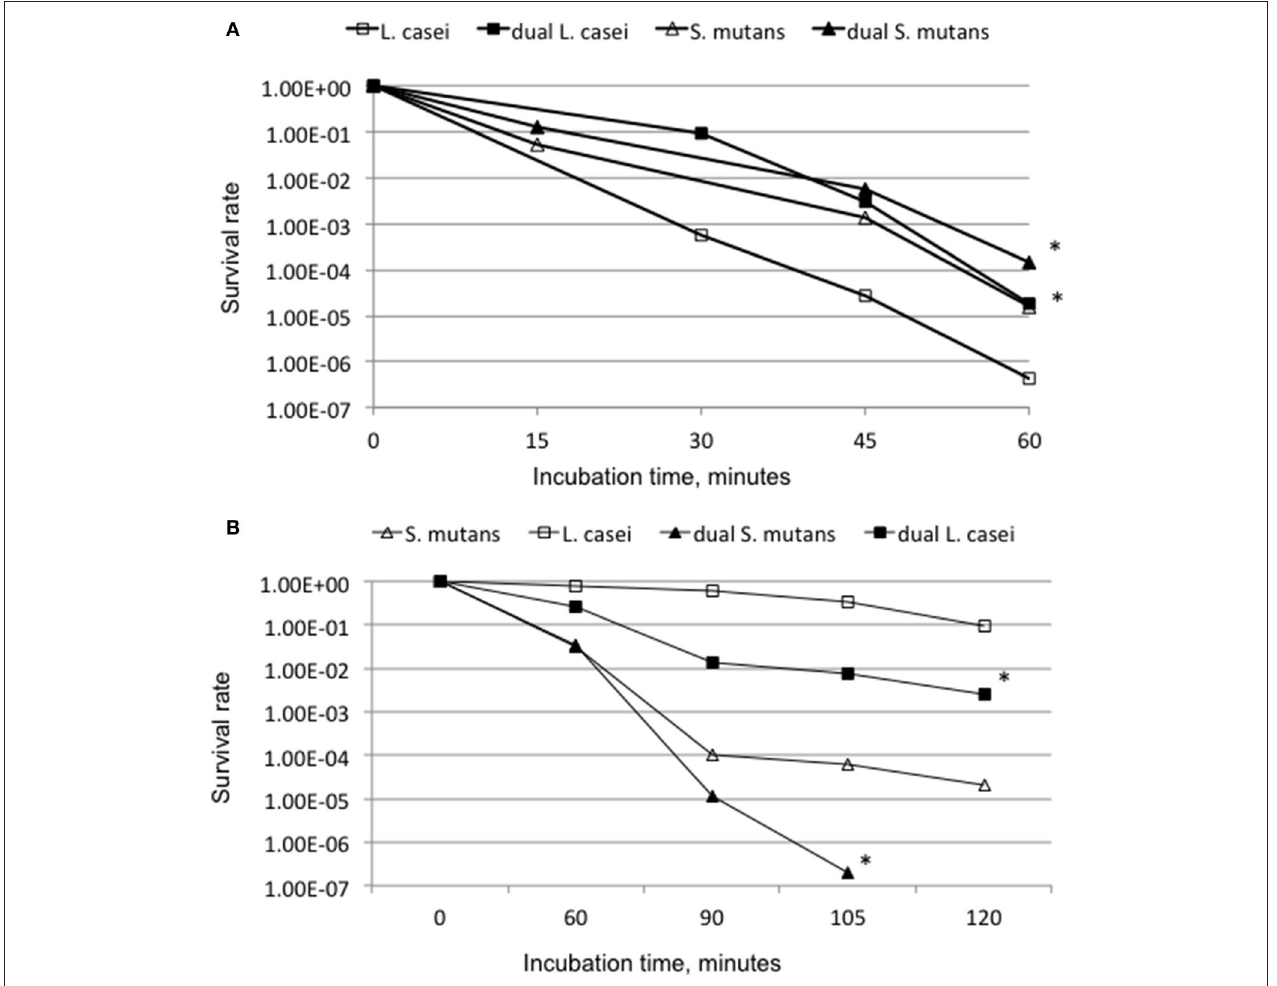
FIGURE 5 | Acid (A) and hydrogen peroxide (B) killing assays. (A) For acid killing, S. mutans , and L. casei biofilms were grown in biofilm medium with glucose and sucrose on glass slides individually or in dual-species for 48h, and acid killing was carried out at pH 2.0 for L. casei and 2.8 for S. mutans . (B) For hydrogen peroxide killing assays planktonic cultures of S. mutans and L. casei were grown overnight in BHI broth, and killing assays were done in glycine buffer containing 0.2% hydrogen peroxide. Data presented here are representatives of more than three independent assays with * indicating significant difference at P < 0.001 in comparison to the respective mono-species